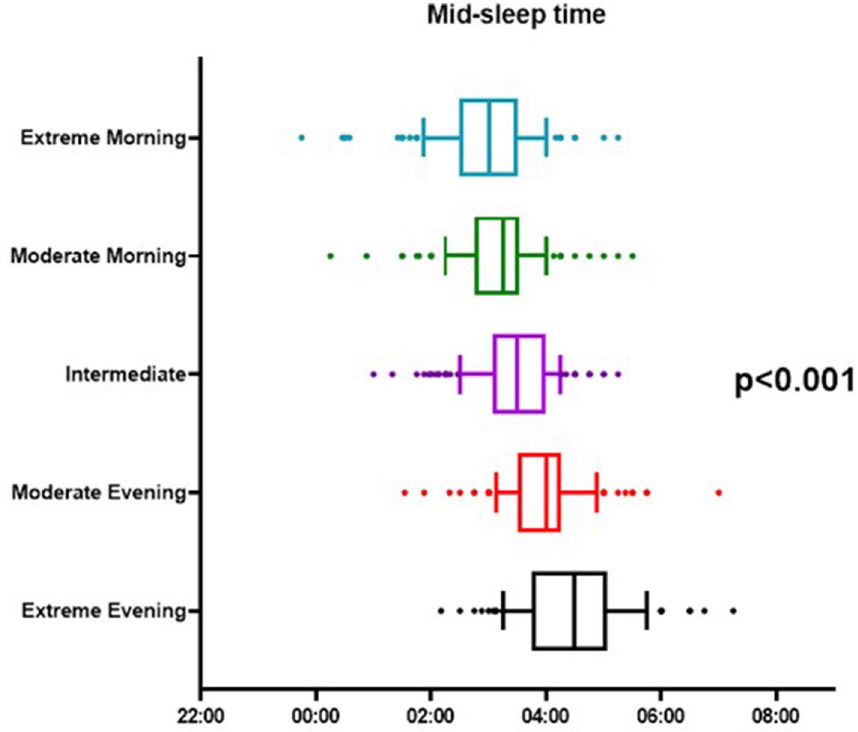
Figure 2. Mid-sleep time by chronotype (n = 685). The mid-sleep times of the 5 chronotypes from extreme morning to extreme evening were 2:55am, 3:11am, 3:29am, 3:58am, and 4:29am, respectively. There is a dose- dependent relationship between mid-sleep time and subjective chronotype (ANOVA, p < 0.001).